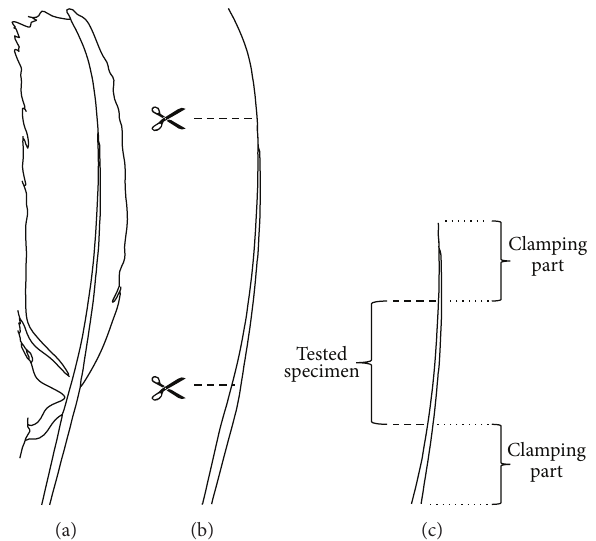
Figure 1: Schematic drawings of flight feather and the sampling of tensile tested specimen. (a) Complete feather. (b) Feather shaft after removing the vane with scissors. (c) Tested specimen with extension parts on its two sides for clamping.